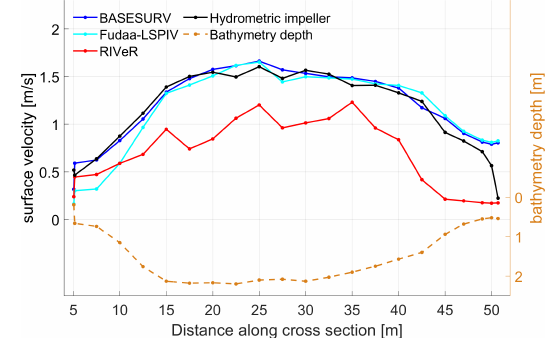
Figure 5. AIV velocity profiles along cross-section AA’